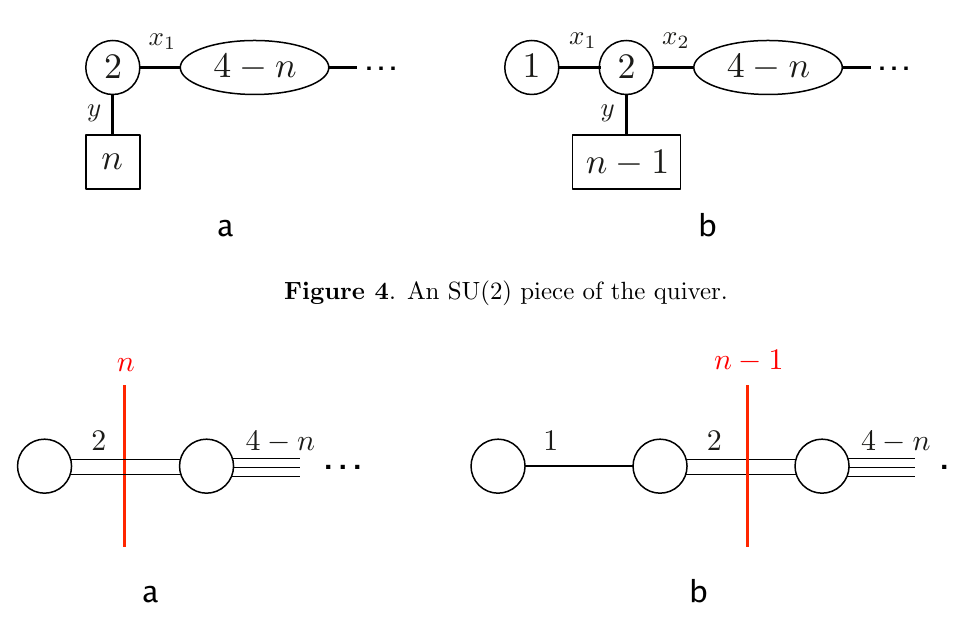
Figure 5 . Brane con(cid:12)gurations for the quiver tails in (cid:12)gure